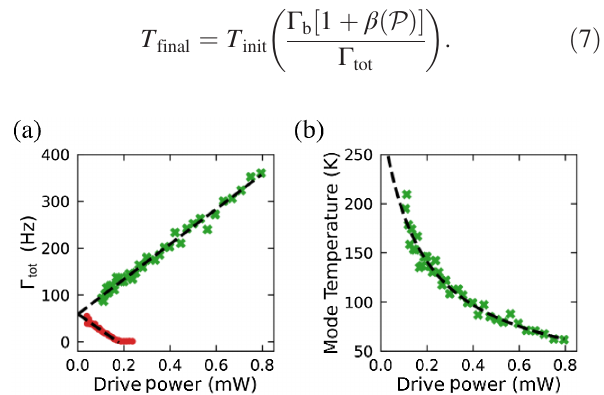
FIG. 6. Magnomechanical cooling. (a) Mechanical linewidth as a function of drive power in vacuum. Red circles demonstrate magnomechanical antidamping and includes the data from Fig. 3(b), green crosses demonstrate magnomechanical damping and includes the data from Fig. 3(c). (b) Effective mode temper- ature of the mechanical mode determined from Eq.